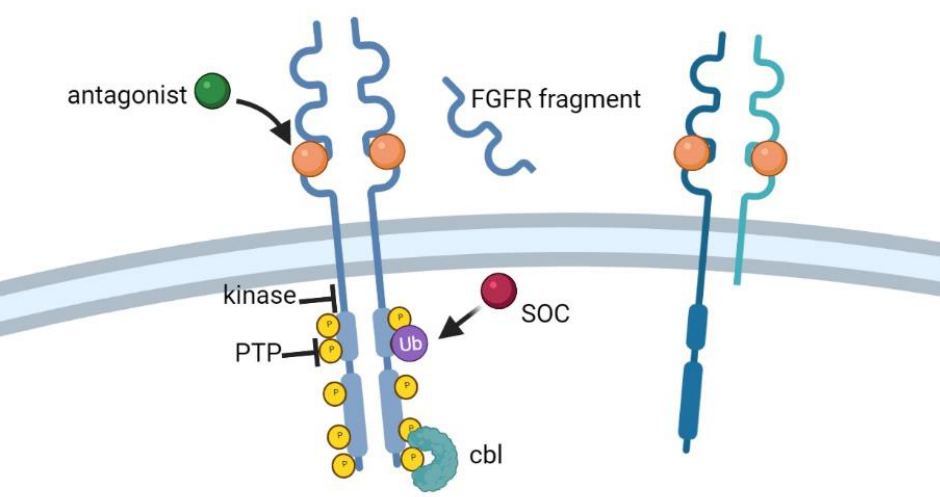
Figure 1. Mechanisms of attenuation and termination of RTK signaling. FGFR dimers and ligand binding are shown. On the left, several mechanisms of downregulation or termination of RTK signaling are shown, such as binding of antagonist molecules, kinase or PTP activity, SOC and CBL regulation of ubiquitination, and degradation of the receptor after internalization. On the right, RTK dimer is composed by the association of one full-length monomer and an RTK truncated form that lacks the KD, generating a dominant negative mutant.